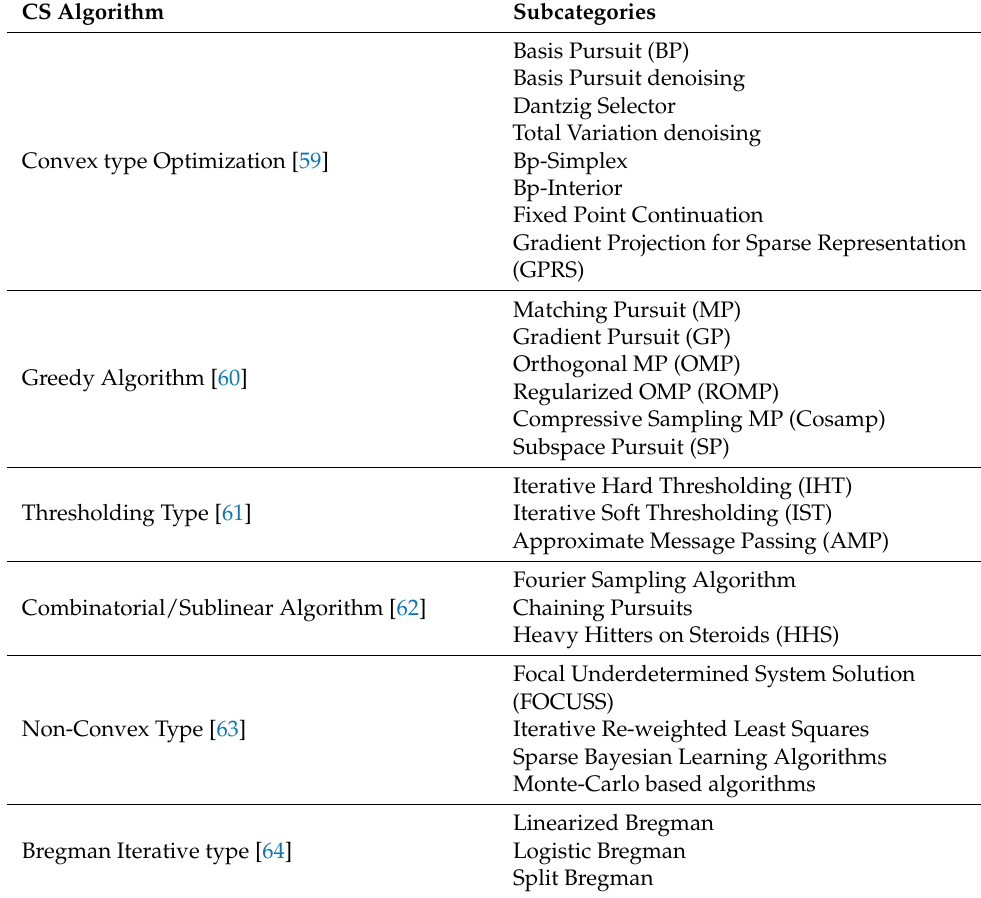
Table 1. The CS reconstruction algorithms and its